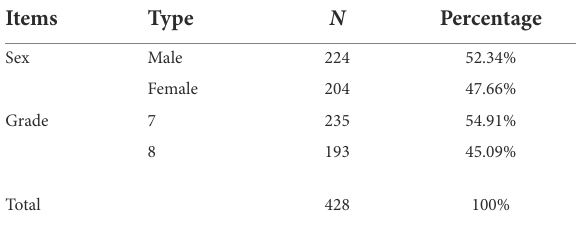
TABLE 1 Descriptive statistics of junior high school student